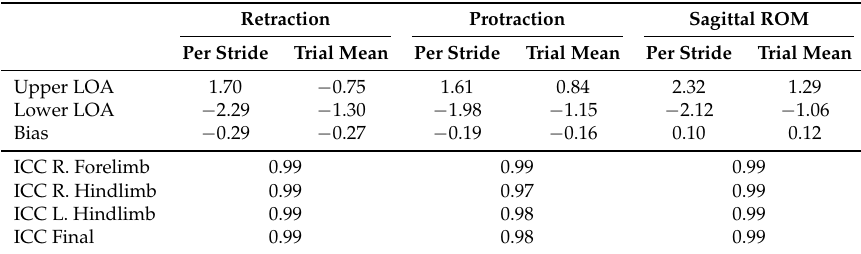
Table 3. Summary of measurement agreement statistics for the sagittal limb angles at walk (values in degrees). ICC: intra-class correlation; LOA: limit of agreement; ROM: range of motion.